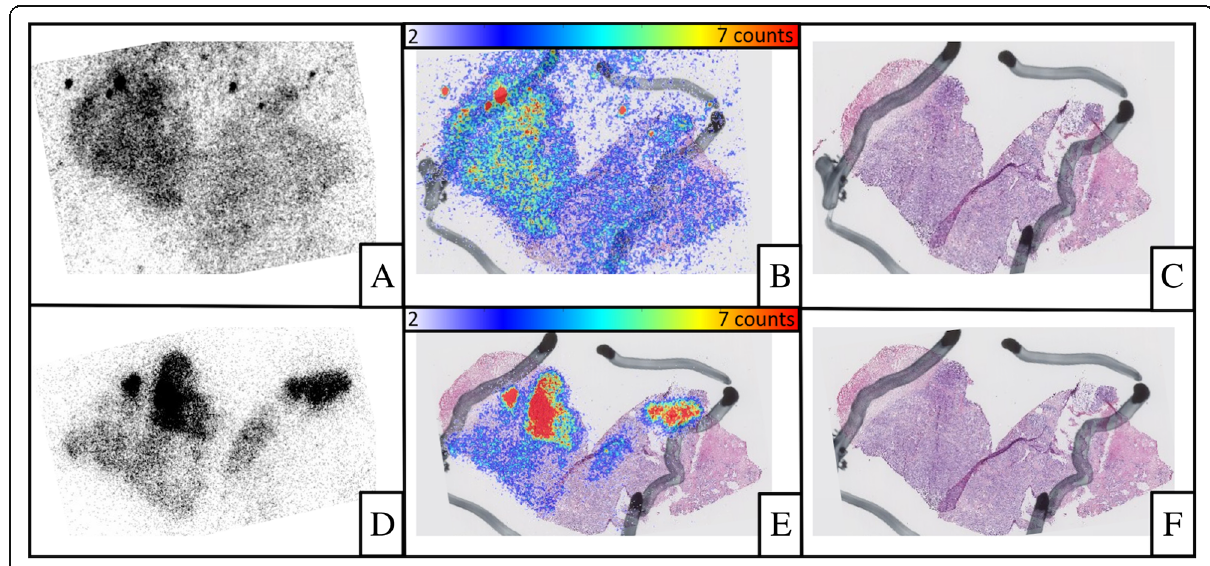
Fig. 2 Comparison between 111 In-RM2 ( a – c ) and 111 In-PSMA ( d – f ) on a high-risk sample: radioactive signal ( a , d ), HES ( c , f ), and fusion images ( b , e ). The black line delimitation corresponds to the tumoral area. There is excellent discrimination between tumor tissue and normal tissue on 111 In-PSMA-617 (TNR = 11.20), while the contrast is somewhat lower with 111 In-RM2 (TNR =